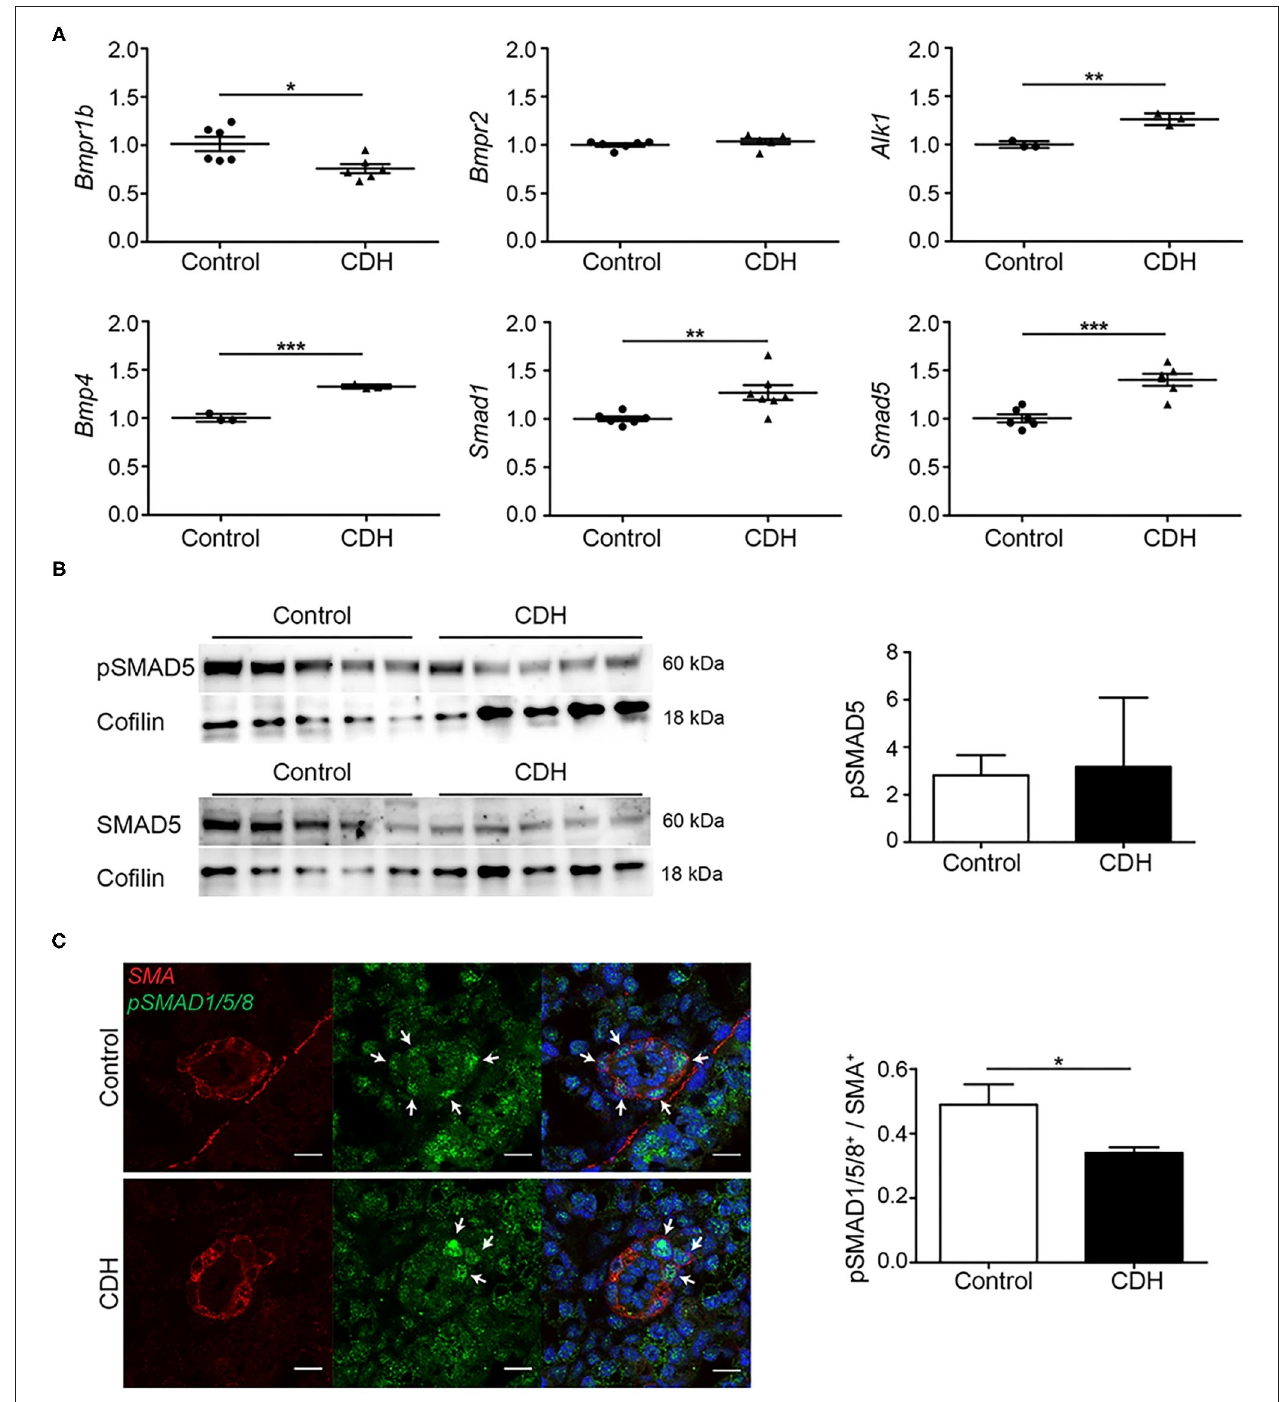
FIGURE 3 | BMP activation is reduced in experimental CDH. (A) Quantitative PCR revealed a significantly decreased lung abundance of Bmpr1b ( p = 0.016) but no differences in Bmpr2 , and increased abundance of Alk1 ( p = 0.003) mRNA transcripts in CDH compared to control. The abundance of Bmp4 , Smad1 , and Smad5 mRNA transcripts was significantly higher in CDH [ p < 0.001, p = 0.009, and p < 0.001, respectively; n = 3 ( Alk1 and Bmp4 ) or 6 (rest) for both groups]. (B) The lung abundance of pSMAD5 was related to the total SMAD5 protein abundance, which was not different between control and CDH samples, where Cofilin was used as a loading control ( n = 5 for both groups). (C) Representative images of immunofluorescence staining indicate a decrease in the ratio of pSMAD1/5/8/ SMA double-positive cells in small pulmonary vessels in CDH lungs ( p = 0.016; n = 3 samples for both groups). Six vessels per sample were counted. Scale bars represent 10 µ m. * p < 0.05, ** p < 0.01, *** p < 0.001. Error bars represent